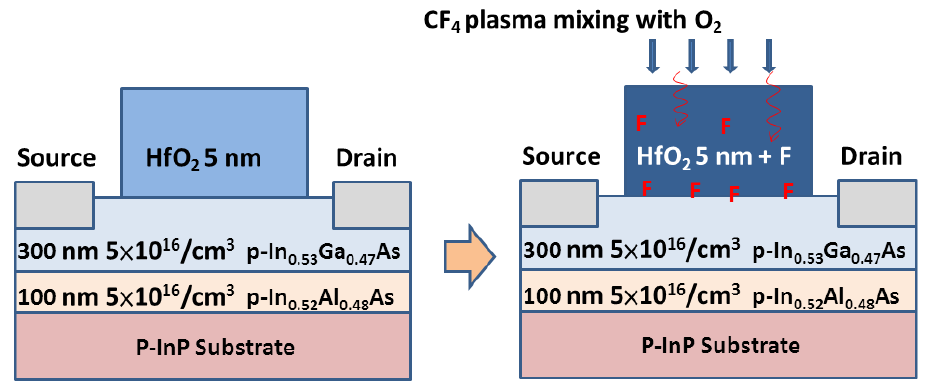
/In Ga As gate stack. Samples 2 0.53 0.47 and O gas (ratio ~10:1) with varied RF power and 4 2